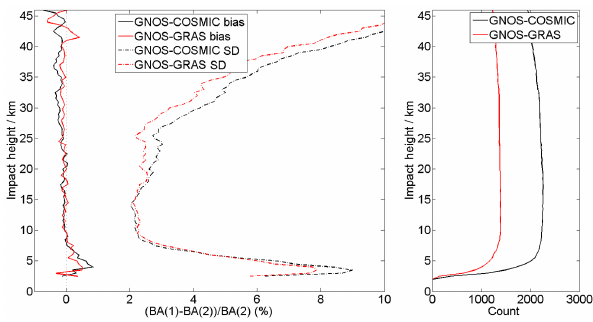
Figure 7. Comparisons of GNOS GPS, COSMIC, and MetOp/GRAS in terms of raw bending angles (from 1 November and 31 December 2013). On the left panel, the solid curves are the mean biases of two pairs, and the dashed curves are the standard deviations. The right panel shows the samples increasing with altitude for the two